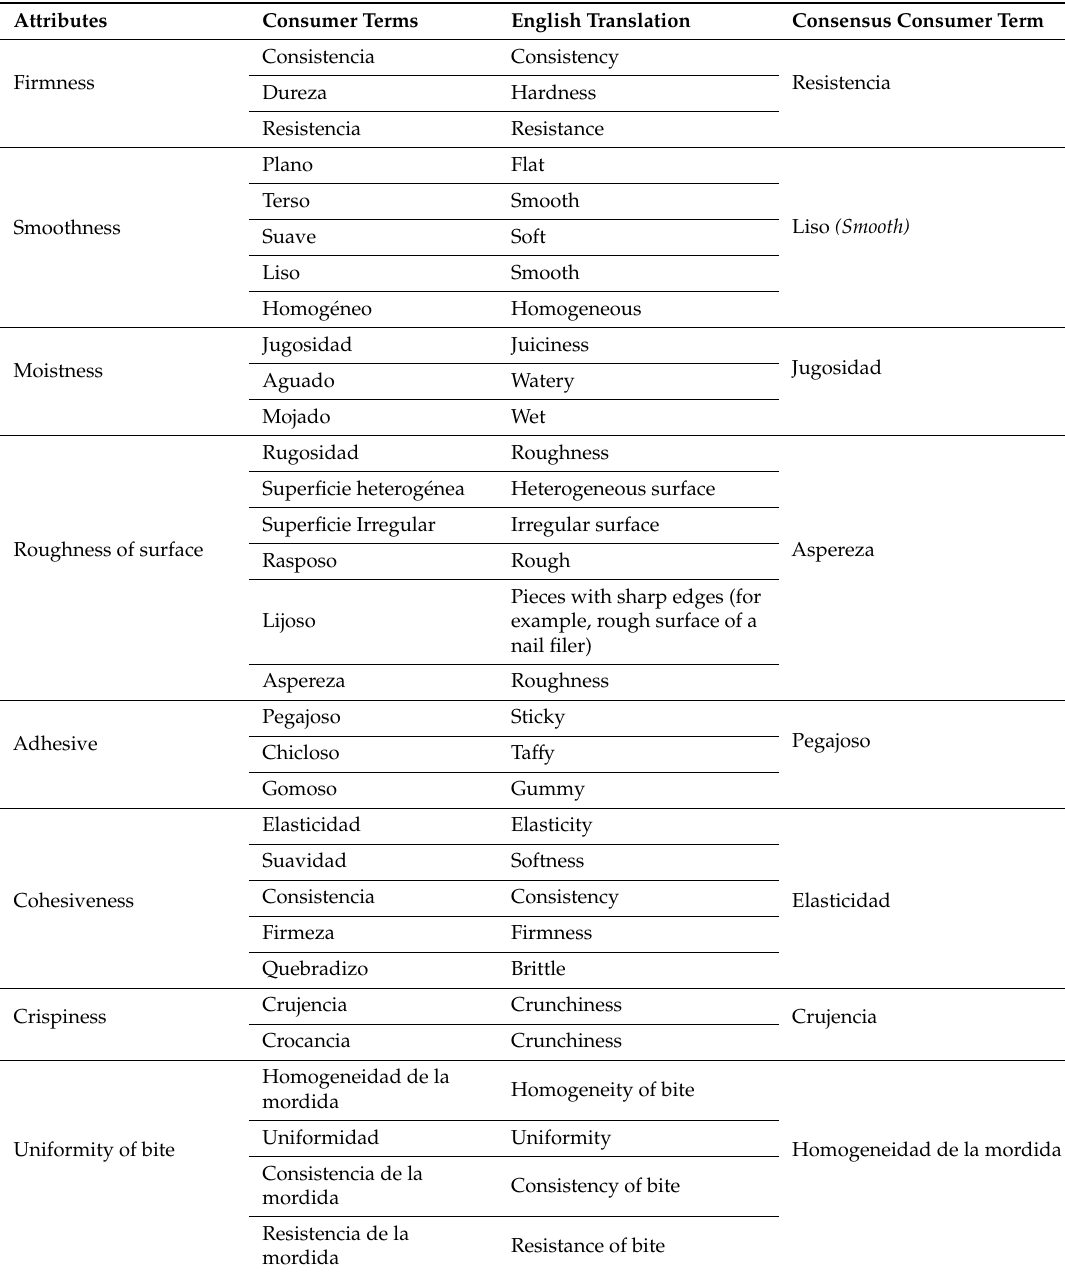
Table 6. Consumer texture terms provided by the Spanish-speaking group.